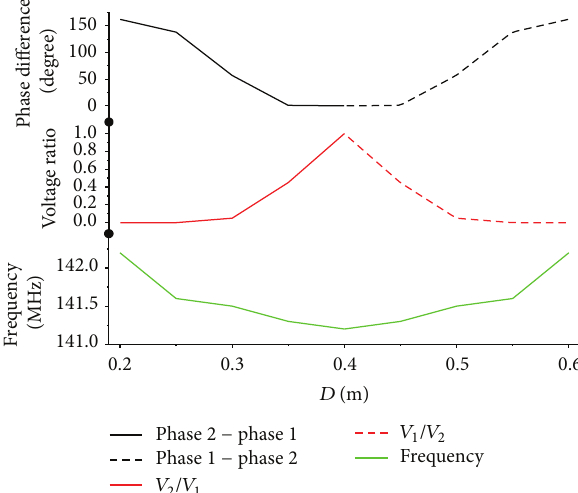
Figure 15: Operating frequency of PTE mat against voltage ratio for different 𝐷 .